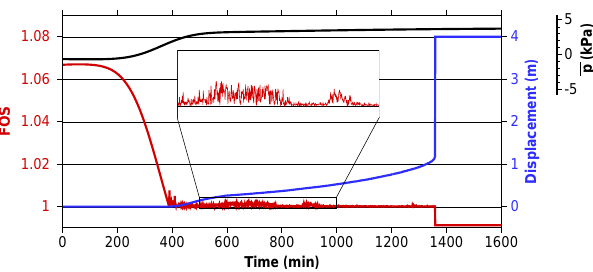
Figure 9. Time series of the factor of safety (red), displacement (blue), and mean pore-water pressure ( p , black) at the center of the clearing ( x = y = 0) for the simulation shown in Figs. 6 and